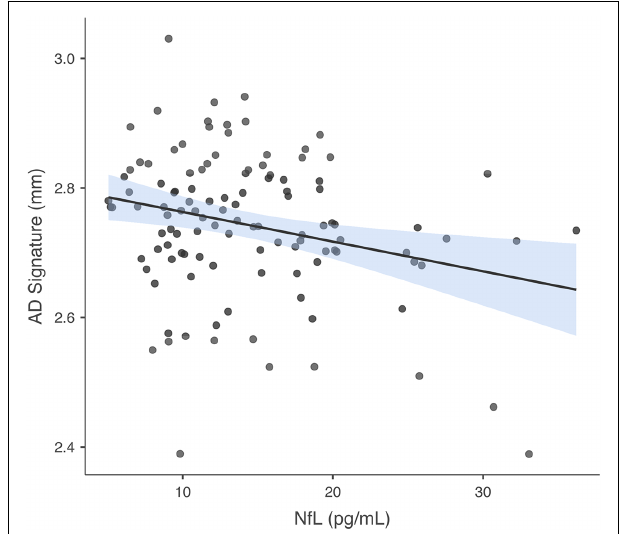
FIGURE 3 | Association between AD Signature and NfL. Scatterplot depicting the raw association between the AD Signature mean cortical thickness and NfL.